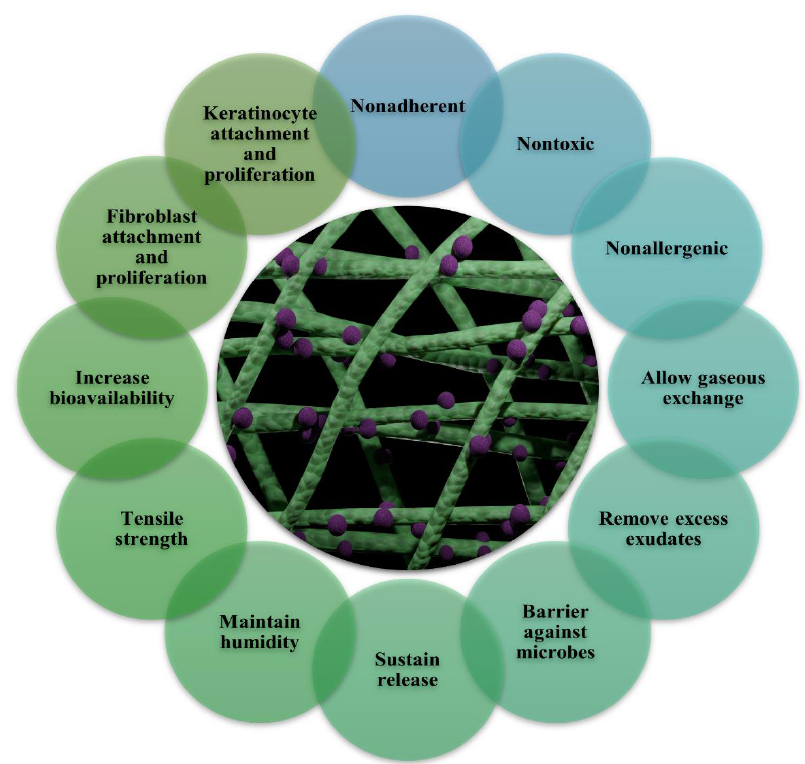
Figure 8. Characteristics of AgNPs containing nanofibers on wound healing.